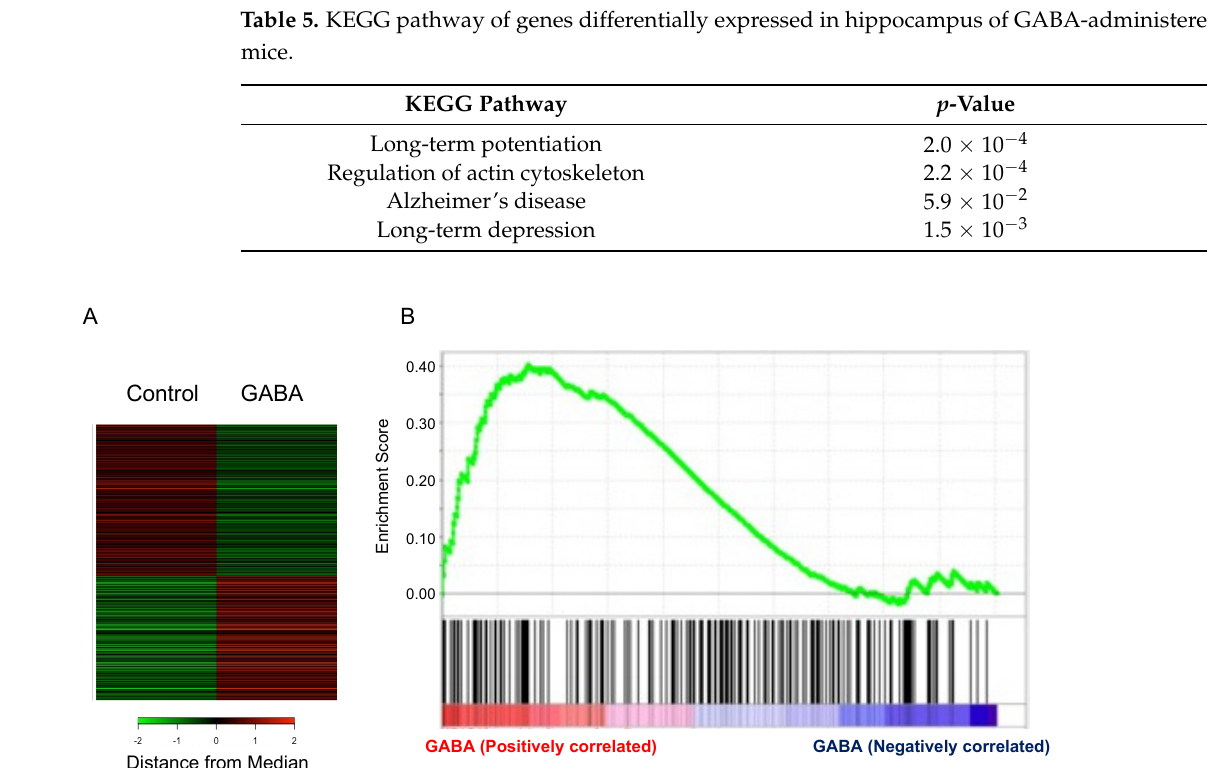
Table 5. KEGG pathway of genes differentially expressed in hippocampus of GABA-administered 294 mice. 295